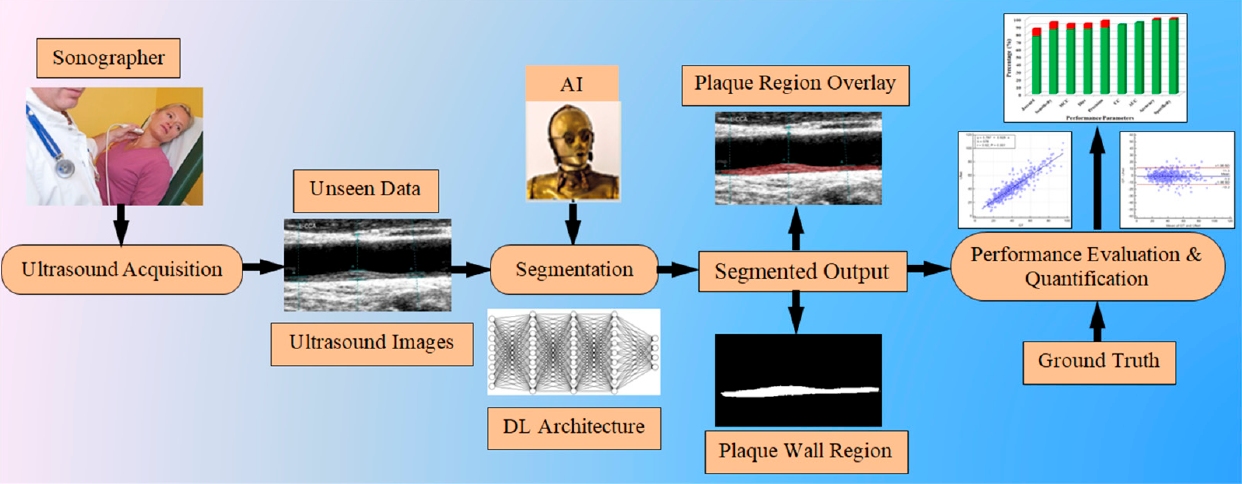
Figure 1. System diagram for unseen data processing.